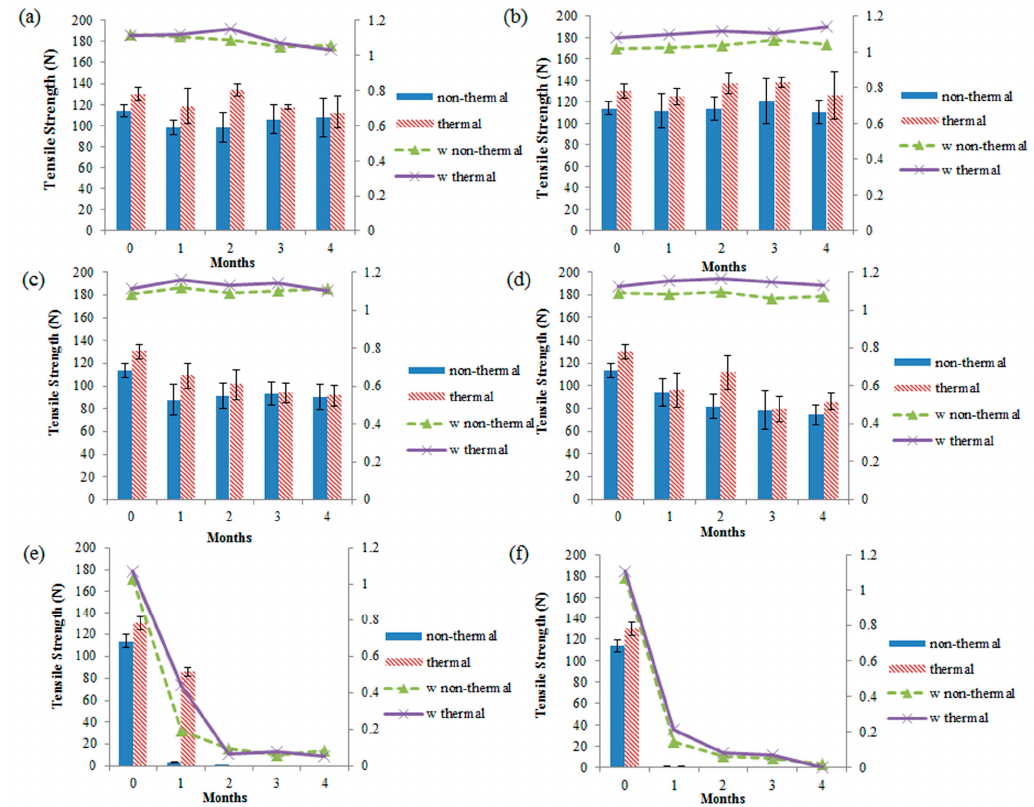
Figure 7. FT ‐ IR spectra of nonwoven geotextiles that are immersed in NaOH at (a) 23 °C and (b) 50 °C.